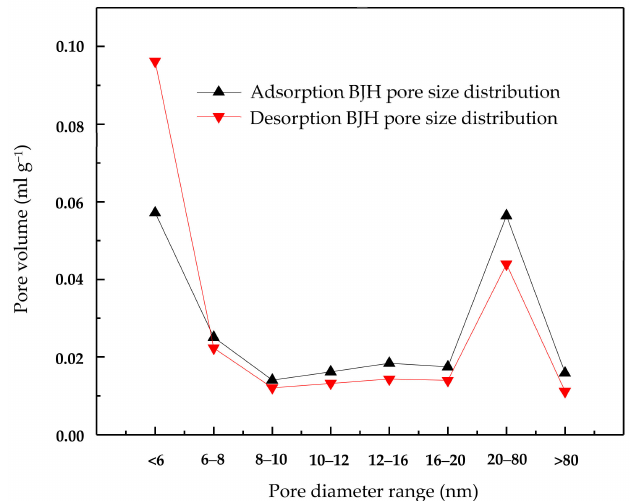
Figure 7. Activated carbon adsorption and desorption BJH (Barrett–Joyner–Halenda) pore size distribution.